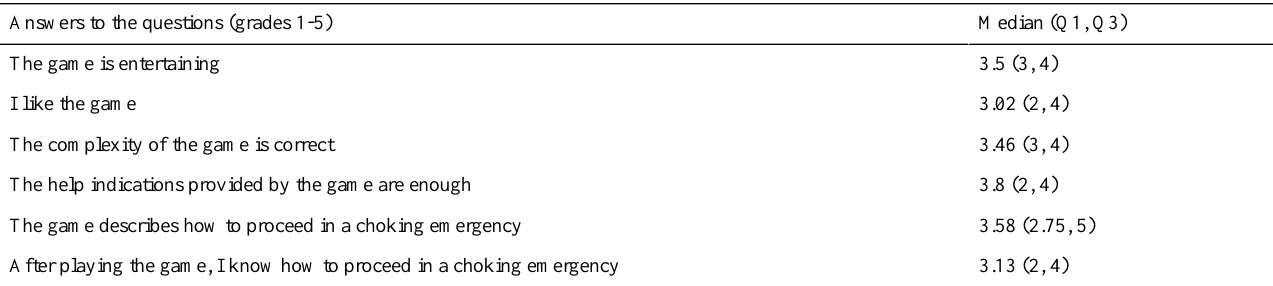
Table 1. Descriptive statistics of the answers to the questions related to the game.